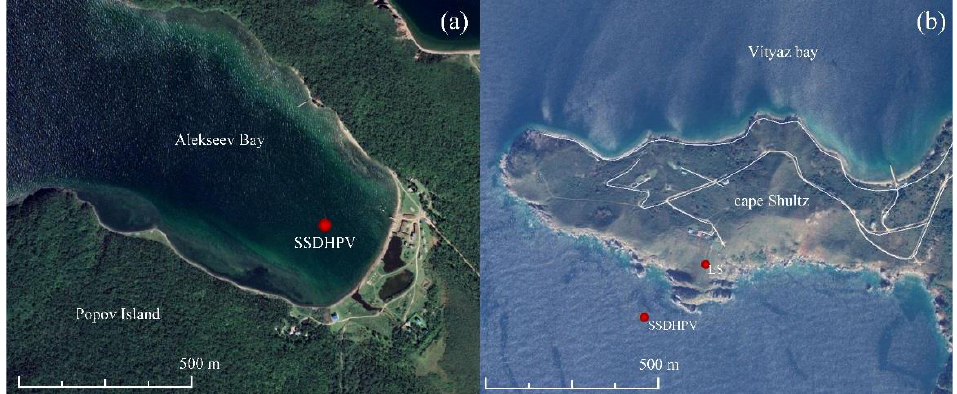
Figure 2. Schematic map of the locations of the supersensitive detector of hydrosphere pressure variations (SSDHPV) and the 52.5-m laser strain meter (LS). ( a ) — Popov island, ( b ) — cape Shultz.